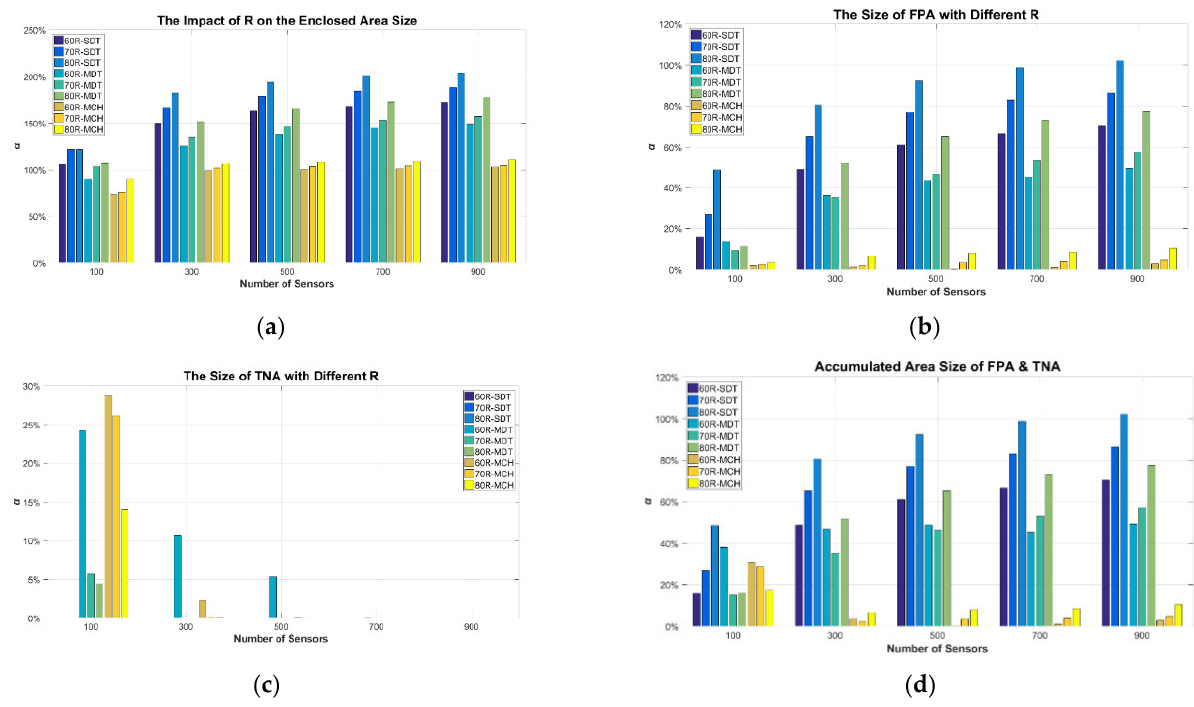
Figure 5. The Impact of the Communication Range on the Enclosed Area. ( a ) The ratio α of the enclosed area sizes. The value of α is the ratio of the area enclosed by an evaluated method over the practice size of the continuous object. An algorithm is said to have high precision if α is close to 100%. ( b ) The ratio α of FPA in the enclosed area. ( c ) The ratio α of TNA in the enclosed area. ( d ) The ratio α of the accumulated FPA and TNA in the enclosed